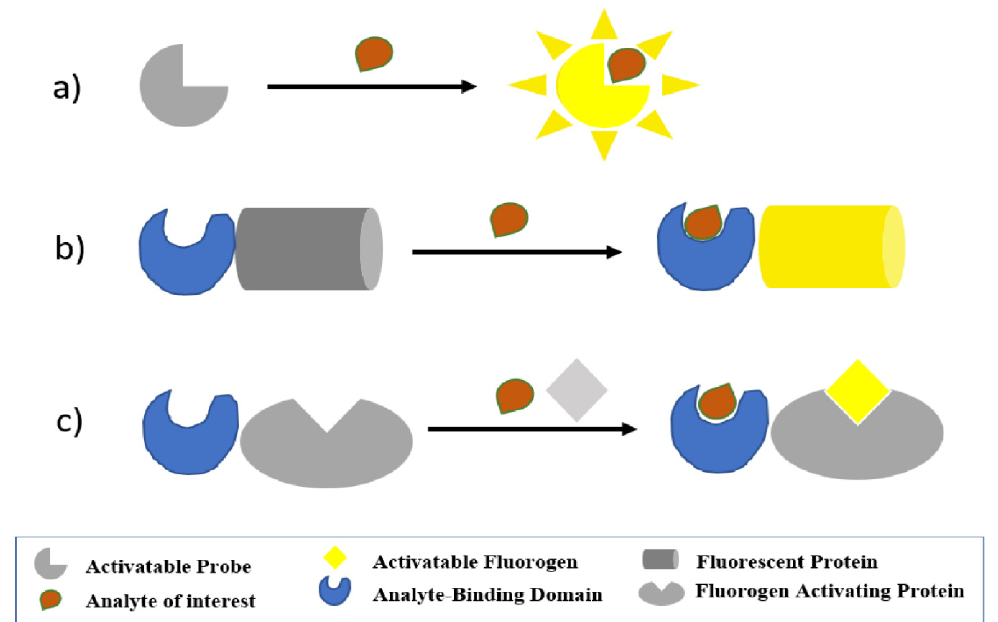
Figure 5. Principle of the main in vivo detection systems. ( a ) Turn on (activatable or smart) probes are exogenously added and they light on upon the binding of the analyte (hydrogen ions, ROS, calcium, ClO, etc.). ( b ) Genetically encoded sensors arise from the fusion of an analyte binding domain to a fluorescence protein; they are expressed in cells and they can change their fluorescence features when binding to ligand. ( c ) Chemical-genetic reporters consist of an analyte binding domain fused to a fluorogen-activating protein tag. These proteins are not fluorescence but they are able to activate a cognate fluorogen that in turn becomes fluorescent when exited. Sensors for ions and other molecules are designed in order to light on only when they bind the analyte.